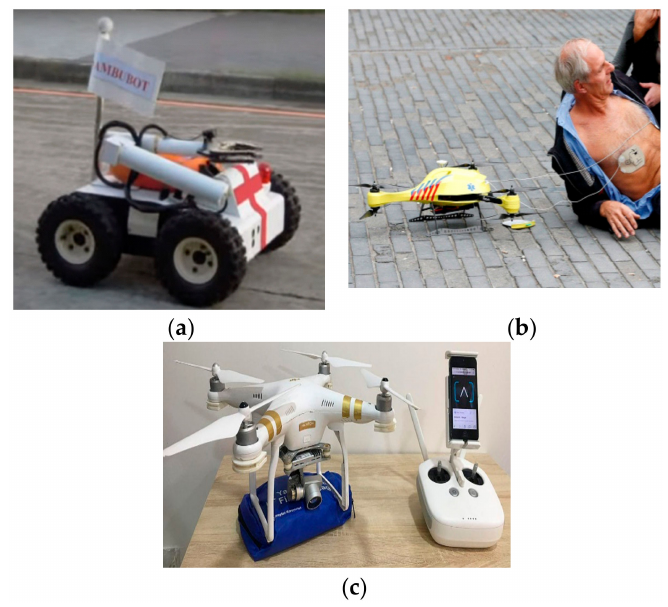
Figure 6. Ambulance robots. ( a ) Ambubot [39]. ( b ) Automated External Defibrillator (AED) for patient recovery [40]. ( c ) Drone carrying a first aid kit (blue) controlled by a smart phone [41].